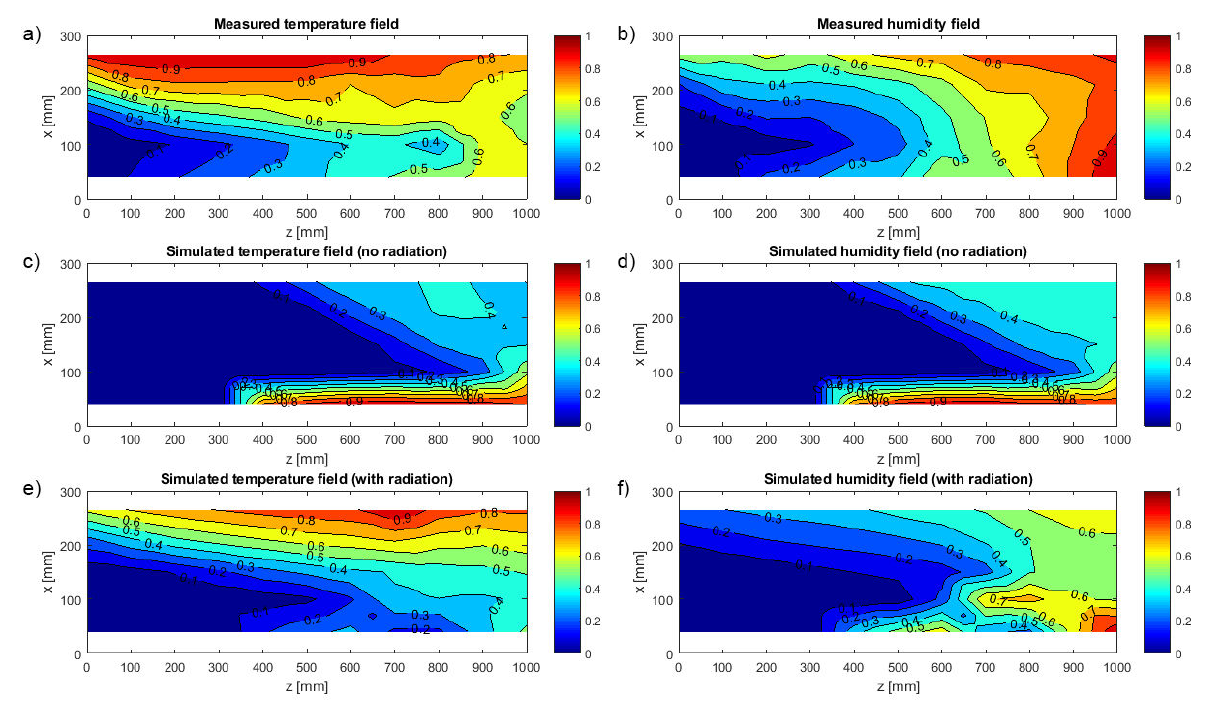
Fig. 7. Case 2 ( ∆ T = 20° C ): Normalized thermal (left) and concentration fields (right) - a,b: experimentally measured; c,d - CFD simulation without radiation; e,f - CFD with radiation (see online version for colors)